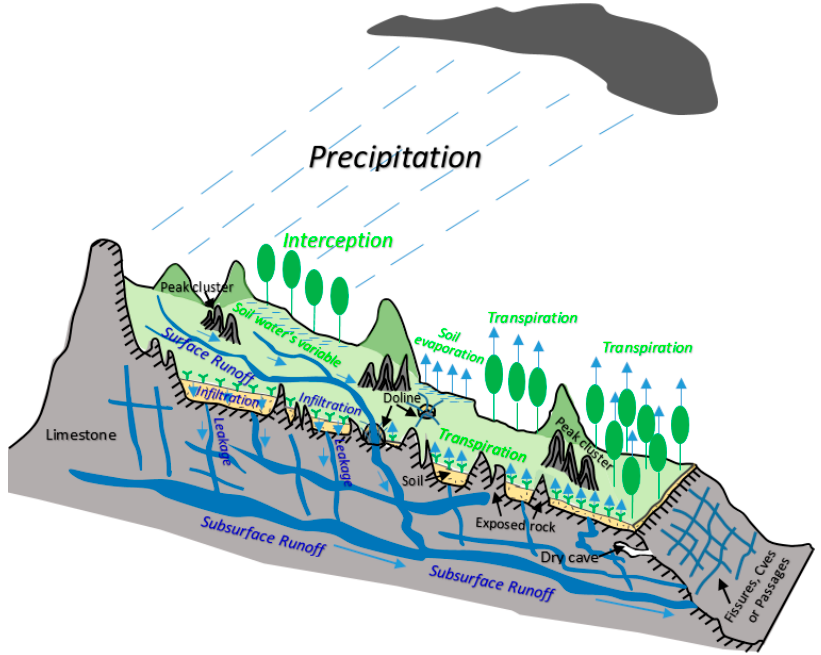
Figure 1. Processes associated with blue water and green water in degraded karst area. Note: Blue arrows imply the direction of water flow. Blue font indicates blue water and green font indicates green water.